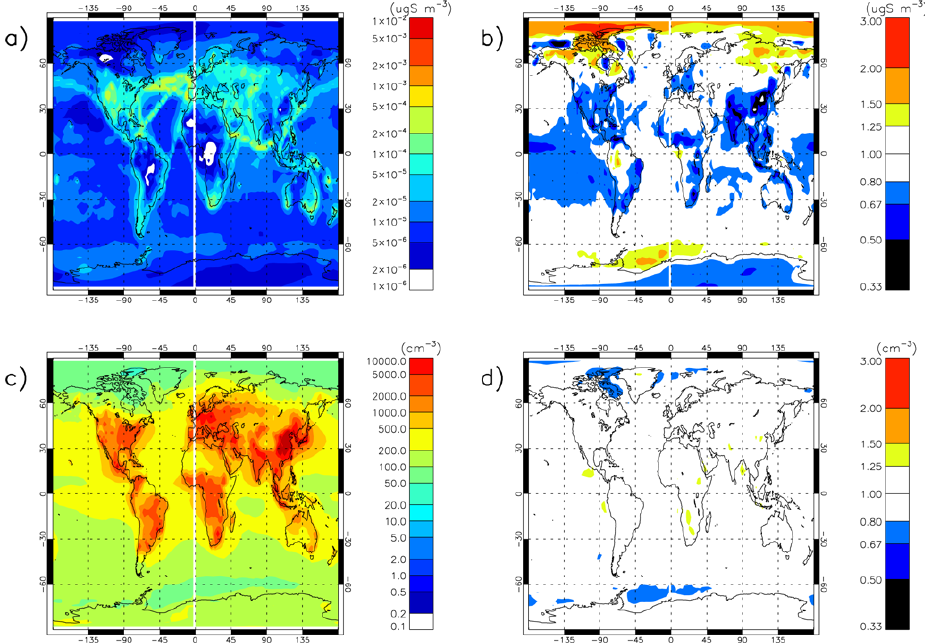
Fig. 8. Global surface maps showing (a) gas phase H 2 SO 4 and (c) CN (dry-diameter > 10nm) concentrations simulated by GLOMAP-mode (v6R) on the annual-mean. The ratio of GLOMAP-mode (v6R) to GLOMAP-bin simulated H 2 SO 4 and CN concentrations are shown in panels (b, d) , respectively. Regions coloured yellow, orange and red in the relative bias maps indicate where GLOMAP-mode is higher than bin by 25–50, 50–100 and 100–200%, respectively, whilst light-blue, dark-blue and black indicate where bin is higher by the same proportions. Regions where the two schemes are within 25% are colored